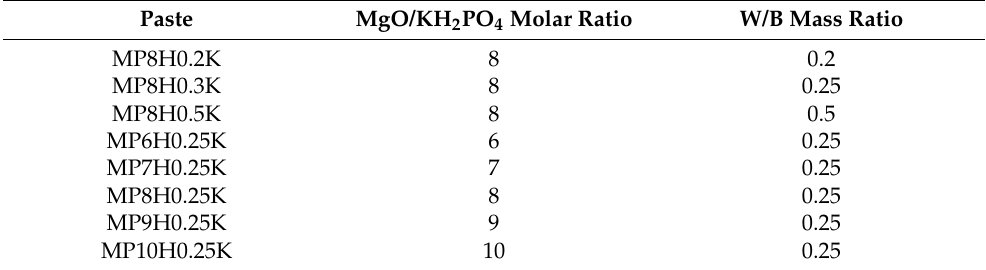
Table 4. Mix proportion of MKPC pastes.